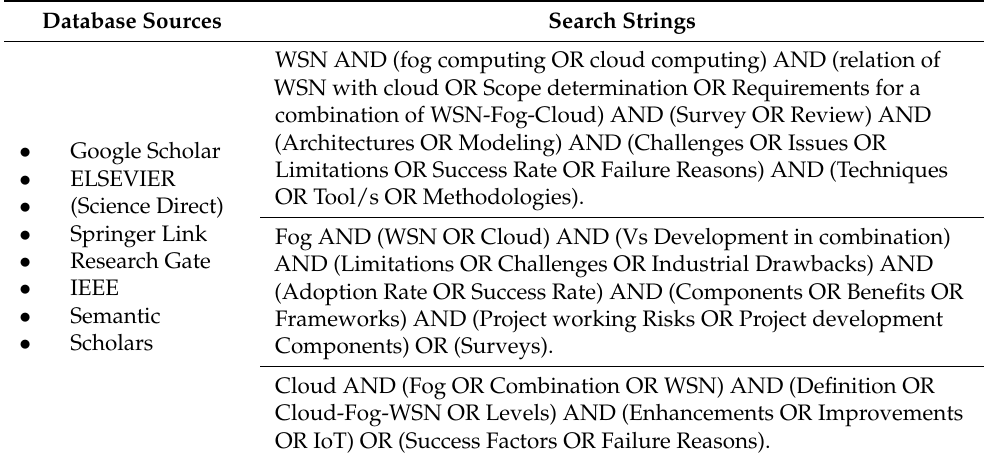
Table 4. Search key strings. Database